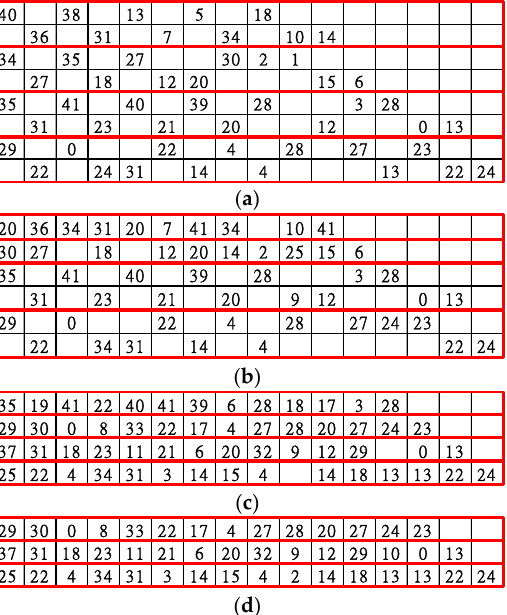
Figure 6. IEEE 802.11ad parity check matrix with R = ( a ) 1/2, ( b ) 5/8, ( c ) 3/4, and ( d ) 13/16.